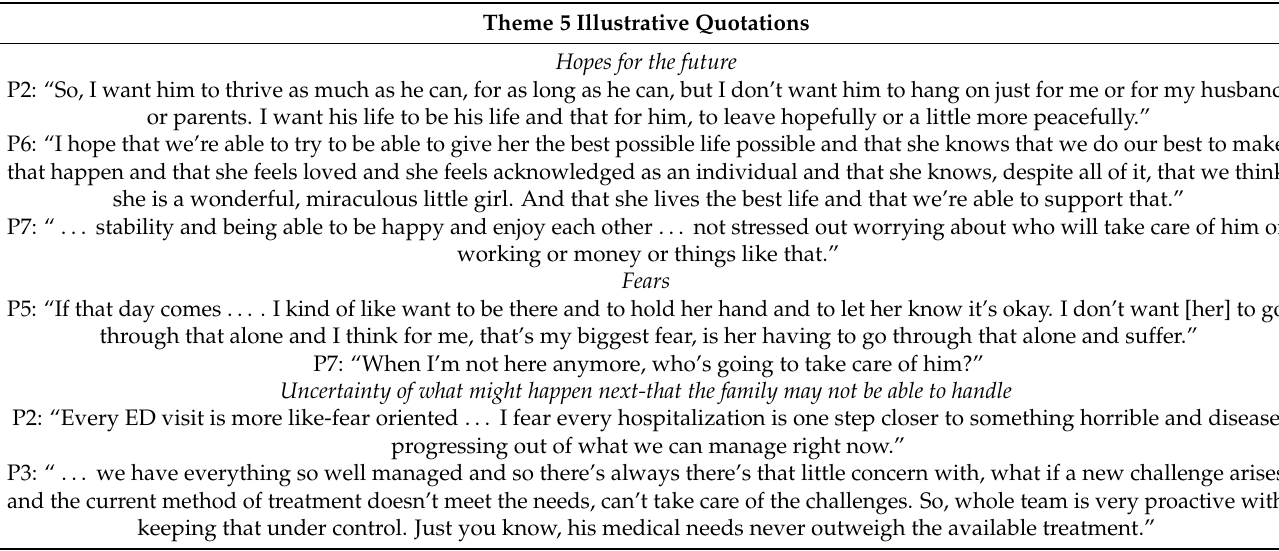
Table 6. Theme 5 Planning for the